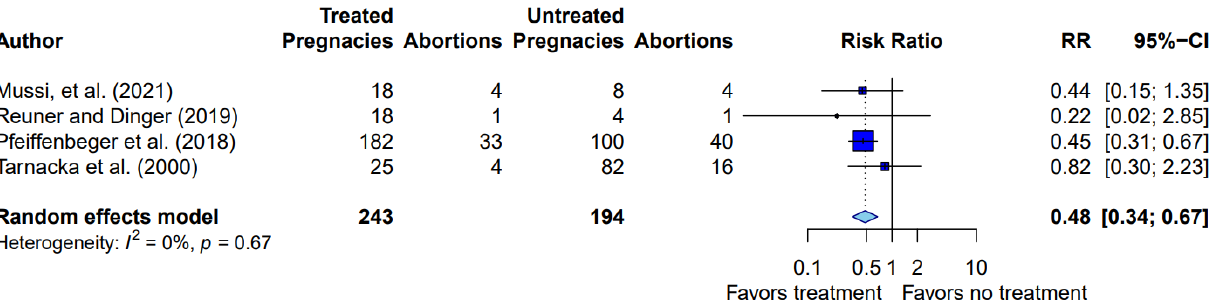
Figure 2. Random effects meta − analysis of studies comparing the risk of spontaneous abortion between treated and untreated patients with WD (squares show risk ratios; square size represents study weight; error bars show 95% confidence intervals; diamond shows pooled effect) .